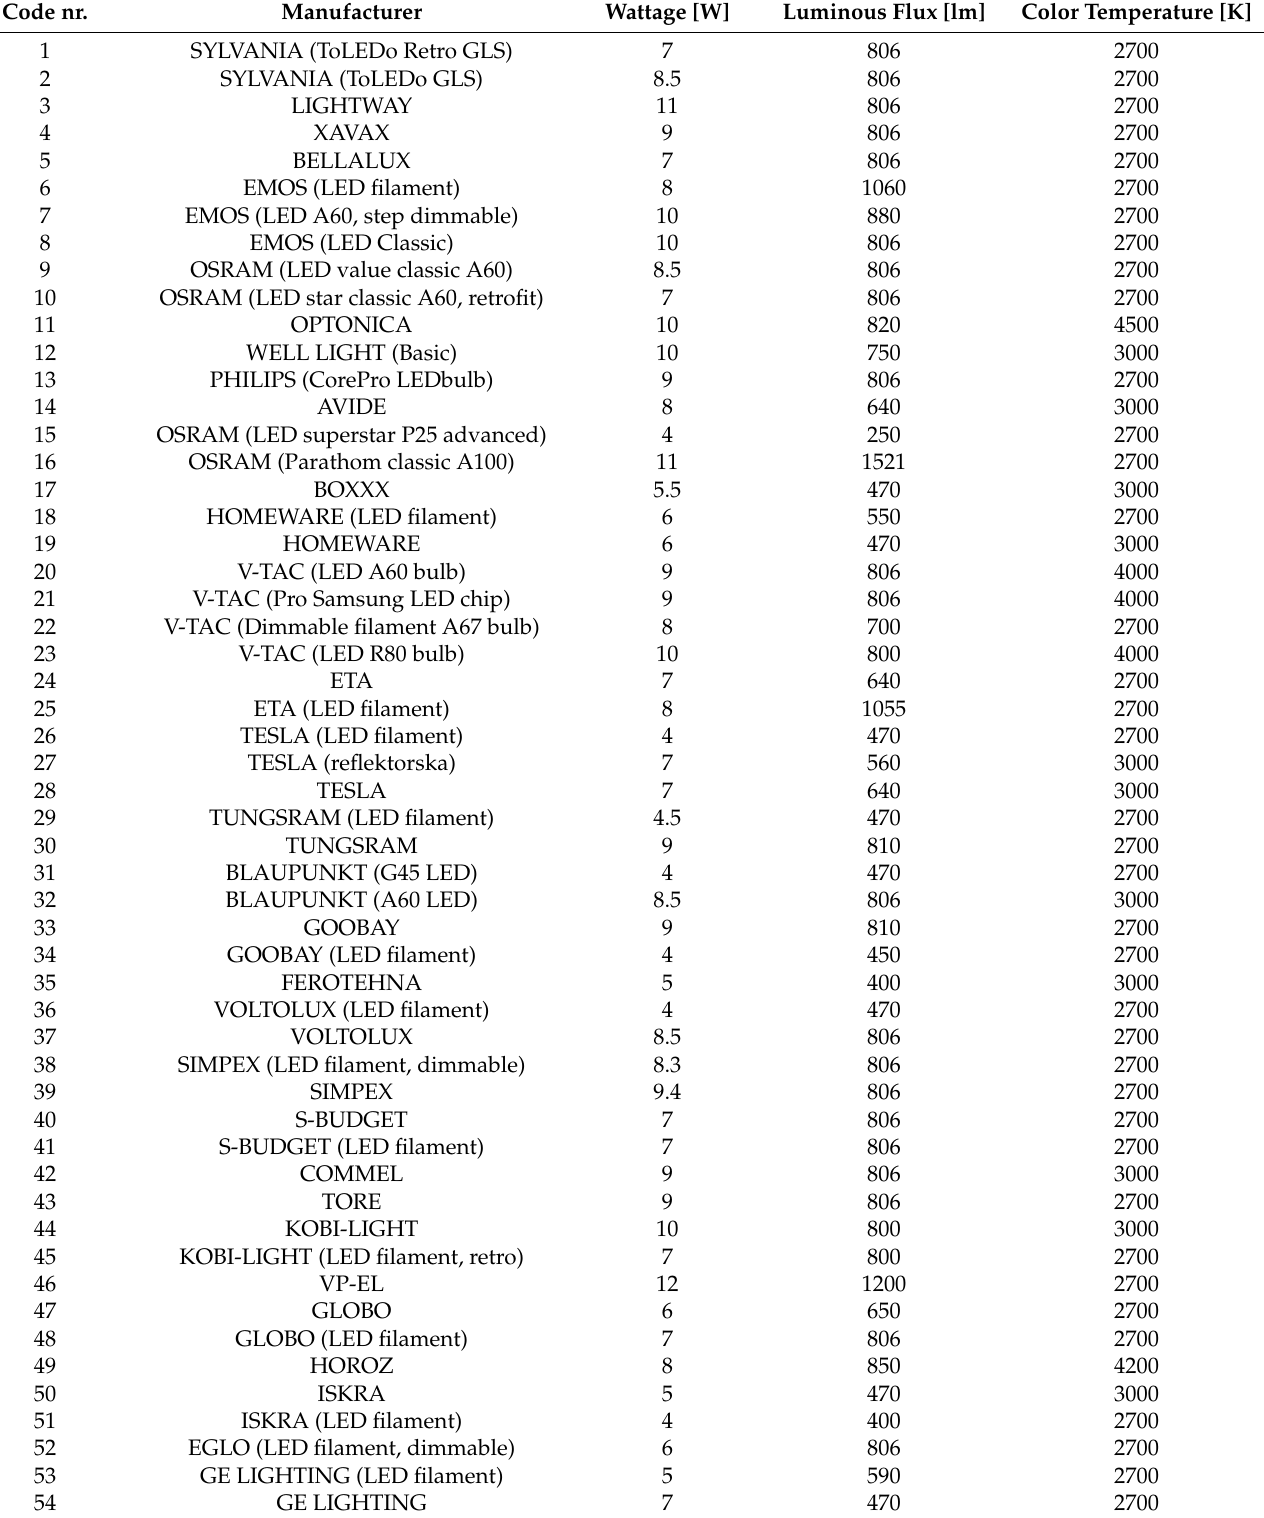
Table 1. List of measured LED light